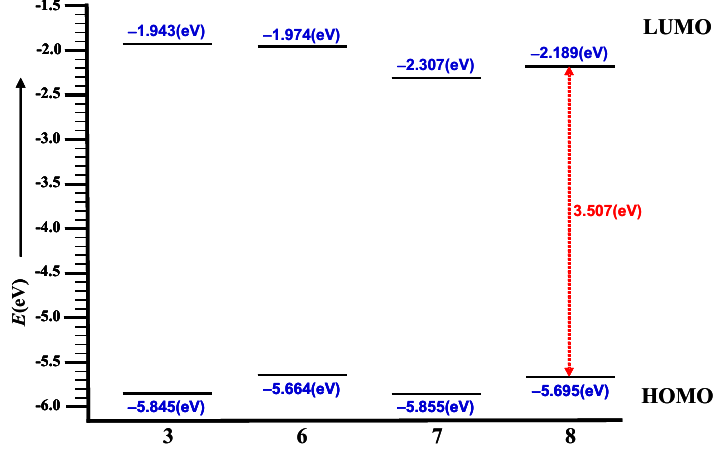
Figure 2. HOMO-LUMO gaps of chalcone derivatives 3 and 6 – 8 .